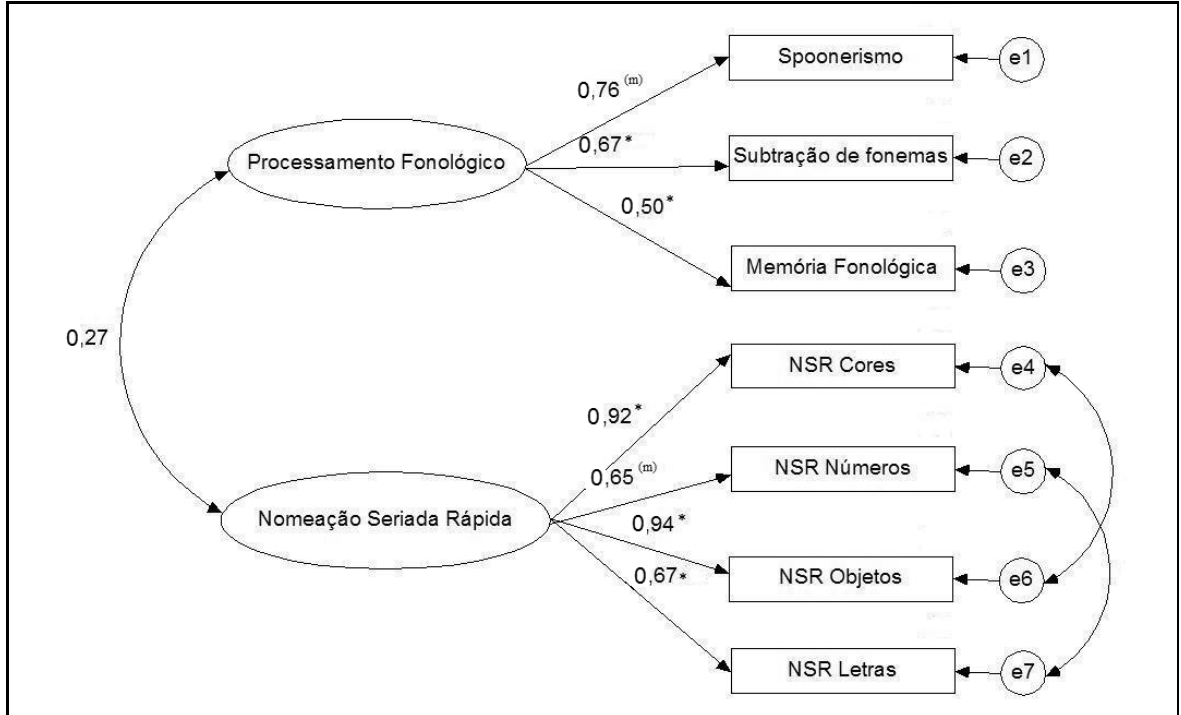
Figur a 4. Diagrama do modelo com dois fatores (representação da proposta de Wolf & Bowers, 1999). Nota : NSR = nomeação seriada rápida; (m) = métrica; * p < 0,05.